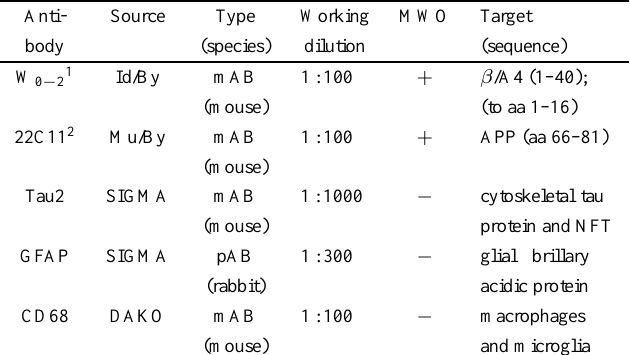
Antibodies used for immunocytochemical